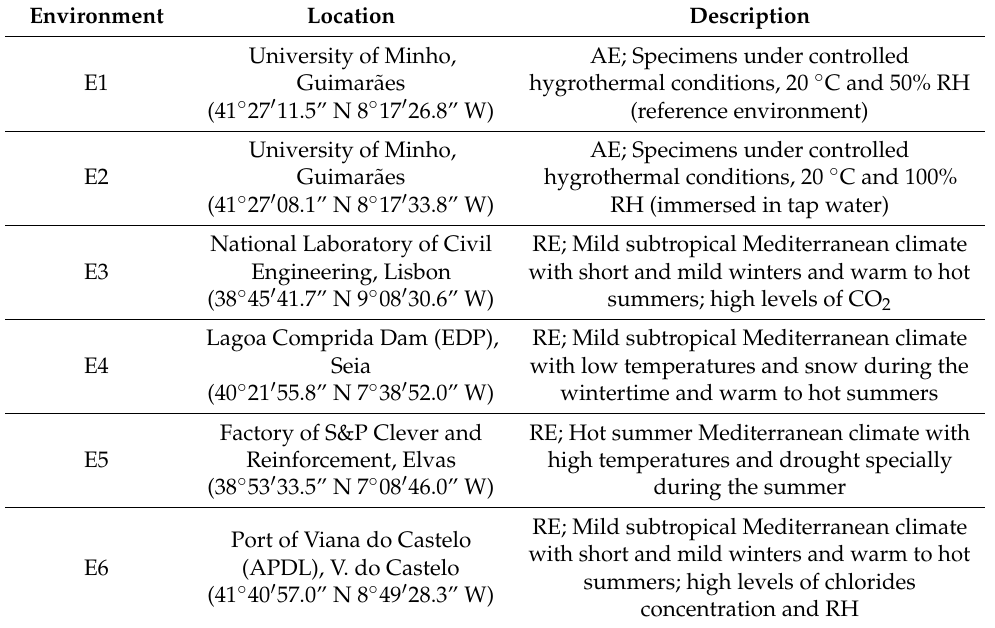
Figure 2. Temperature and relative humidity recorded in environments ( a ) E1 and ( b ) E6.